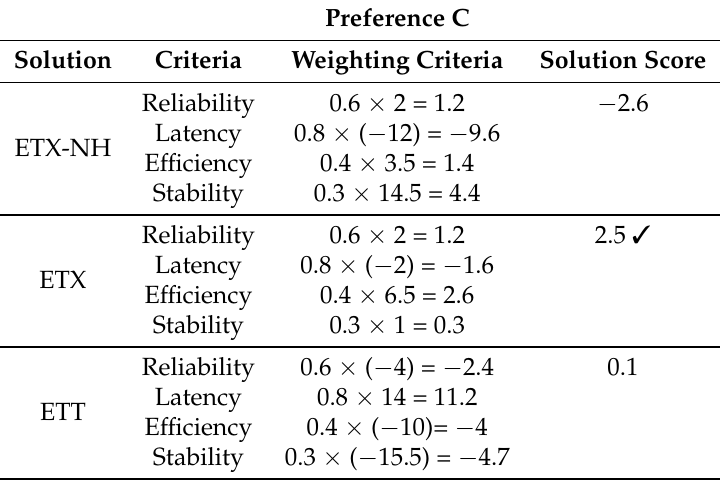
Table 8. Solution scores after weighting for preference C.